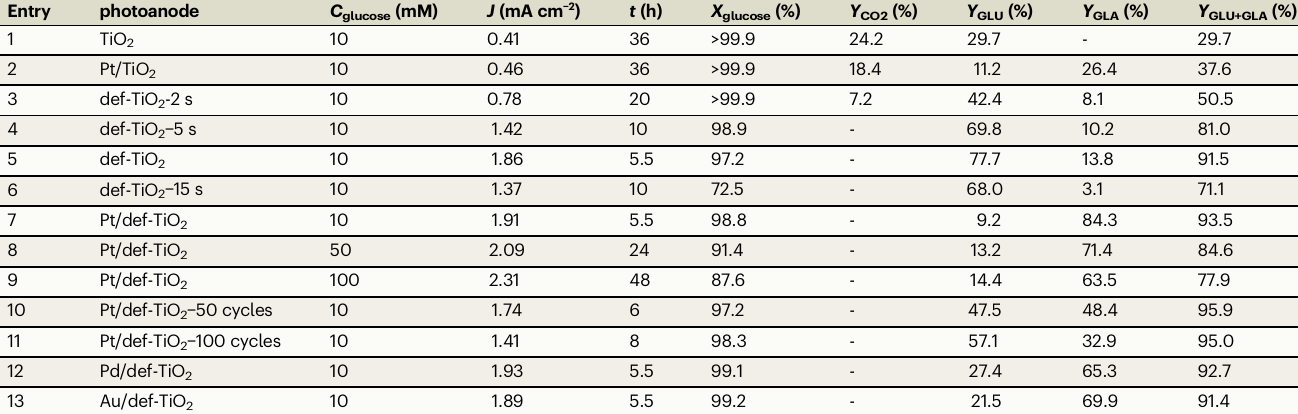
Table 1 | Photoelectrochemical oxidation of glucose at 0.6 V RHE in 1 M KOH with glucose